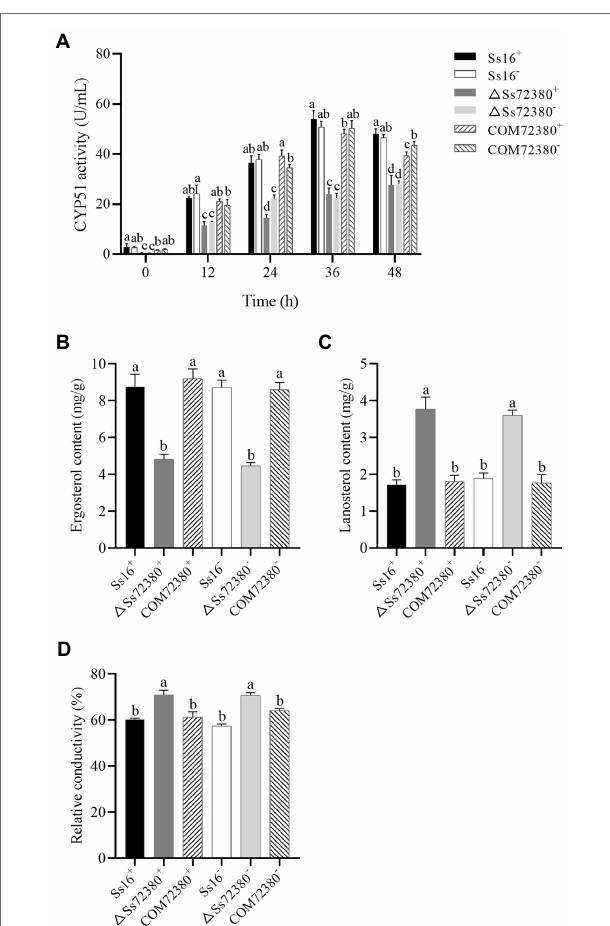
FIGURE 5 | Effect of the SsCI72380 gene on cytochrome P450 sterol 14 alpha-demethylase (CYP51) activity (A) , ergosterol content (B) , lanosterol content (C) , and the conductivity (D) in S. scitamineum . Bars indicate the SE derived from three independent replicates. In the same group, different lowercase letters represent a difference at the 0.05 level.